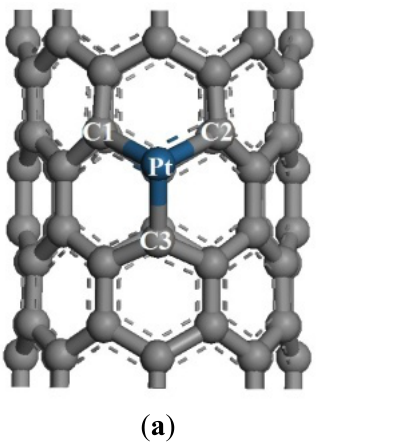
Figure 1. Structural model of Pt-SWCNTs. ( a ) Front view; ( b ) side